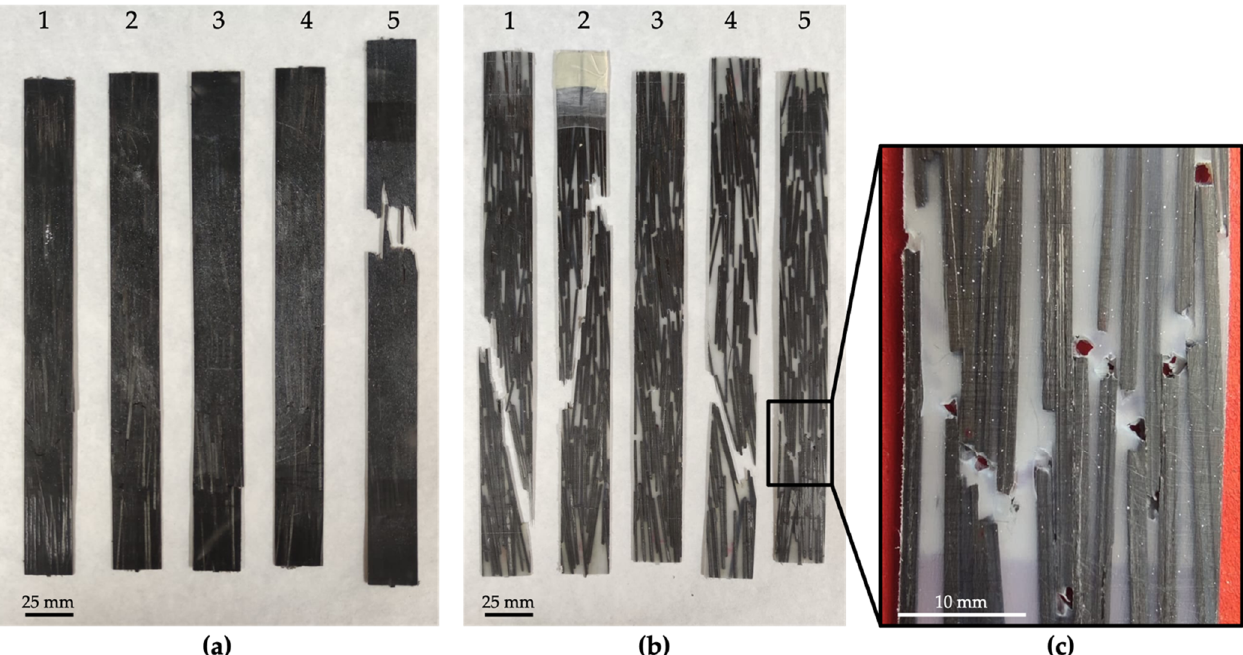
Figure 5. Tensile test specimens. ( a ) PA11 composites, ( b ) PA12 composites, and ( c ) detail of the failure area of a PA12 composite specimen. The color difference is due to the fact that PA11 is black, while PA12 is white.